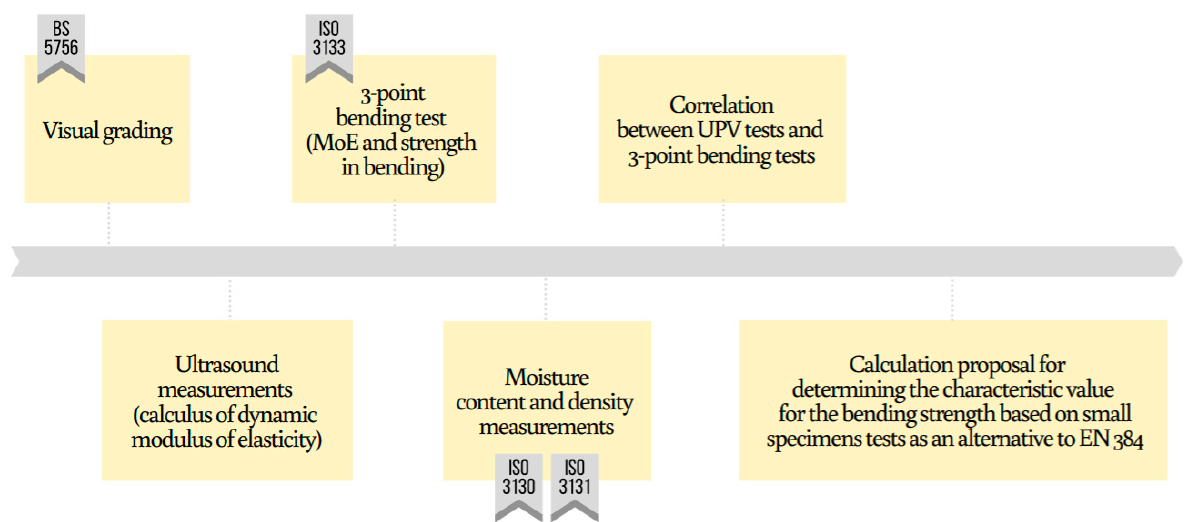
Figure 2. Timeline of the methodology adopted.